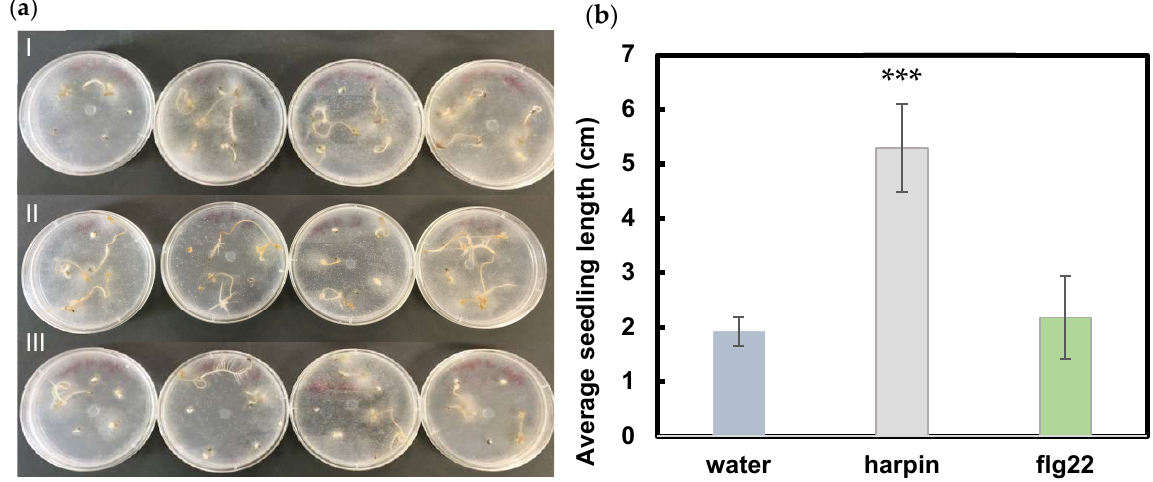
Figure 1. Effects of harpin and flg22 on seedling growth in the presence of P. aphanidermatum . ( a ) Seedlings grown on agar plates for 7 dpi with P. aphanidermatum . I. water control. II. harpin. III. flg22. All four biological replicates for each treatment, of one experimental replication, are shown. ( b ) Average length of seedlings following a 48 h seed imbibition with harpin or flg22 and then 7 d of growth, post inoculation. Significance of means was determined using a Student t -test in comparison to the water control. *** indicates p ≤ 0.001.